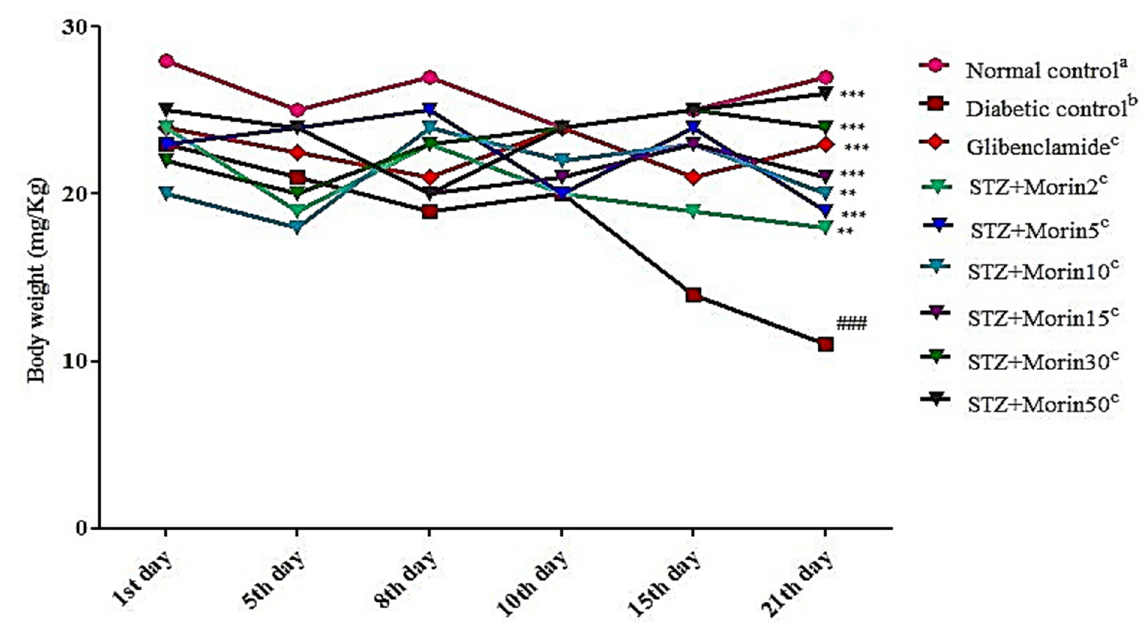
Figure 2. Effects of various treatments on body weight in STZ-induced diabetic rats (the values are expressed as mean ± SEM. Each value corresponds to a mean of eight animals ### p < 0.001; comparison of normal control a vs. diabetic control b using Student’s t-test , ** p < 0.01, *** p < 0.001; comparison of diabetic control b vs. glibenclamide c and morin c treated groups using one way ANOVA followed by Dunnett’s post hoc multiple comparison test).